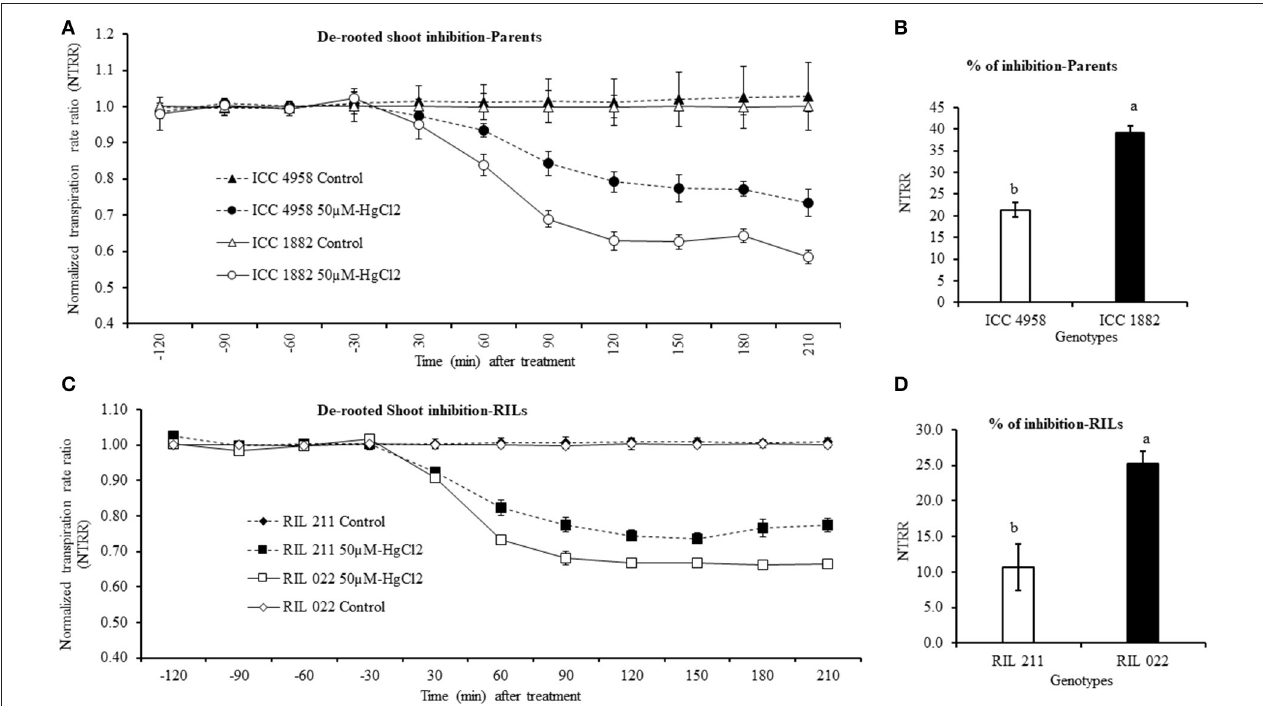
FIGURE 9 | Decline in de-rooted shoot transpiration of four chickpea genotypes contrasting for plant vigor to the aquaporin inhibitor (50 µ M-HgCl2). The graph (A) represents de-rooted shoot inhibition of parents. In this graph the dashed line with closed circle symbols represents ICC 4958 and the solid line with open circle symbols represents ICC 1882 genotype. The graph (C) represents de-rooted shoot inhibition of progeny (RILs). In this graph the dashed line with closed square symbols represents RIL 211 and the solid lines with open square symbols represent RIL 022 genotype. The graph (B,D) represents percentage of aquaporin inhibition in parents and progenies. Each treatment data points represent the NTRR means ( ± SE) of six replicates per genotype. Bars with different letters are significantly different ( P =